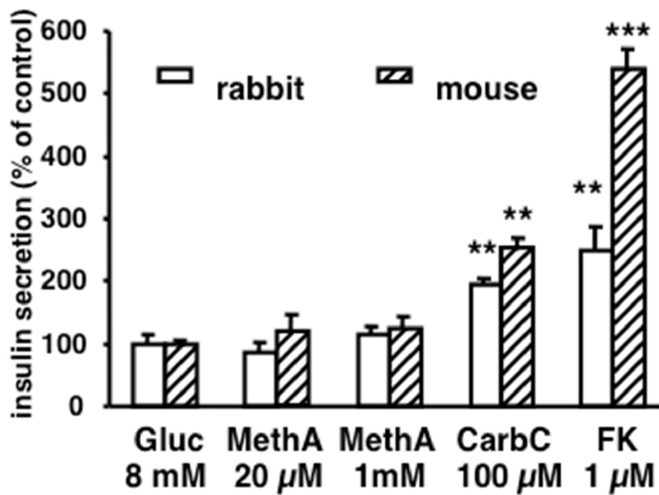
Figure 6. Absence of methylamine direct activation of insulin secretion by islets of Langerhans isolated from rabbit (open bars) or mouse pancreas (cross-hatched bars). Values represent mean ± SEM of insulin release by islets incubated for 1 h with 8 mM glucose (Gluc) without (control set at 100%) or with the indicated doses of methylamine (MethA), carbachol (CarbC), or forskolin (FK). For each condition, 15–23 batches of islets were used. Basal insulin release was 16.5 ± 1.2 µ IU / mL / islet / h for rabbit and 13.9 ± 1.6 µ IU / mL / islet / h for mouse. Significantly different from control at: ** p < 0.01; *** p < 0.001, by t